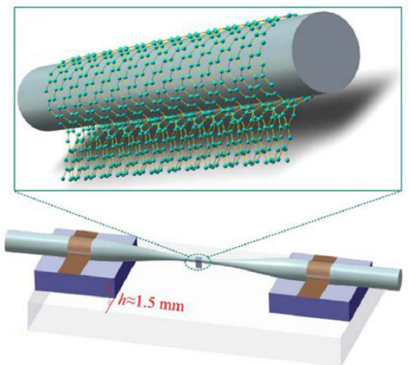
Figure 11. The GCNW saturable absorber. Reprinted with permission from reference [112]. Copyright Springer Nature, 2016.